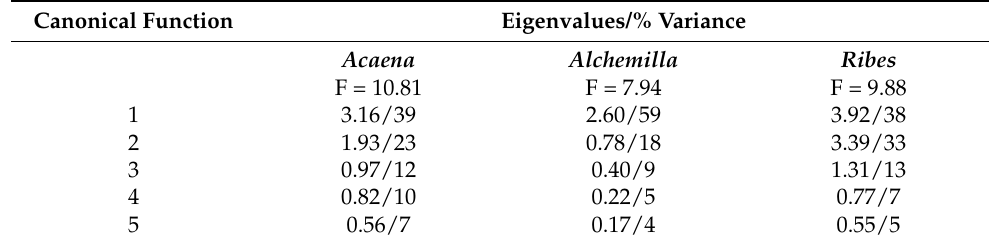
Table 3. Eigenvalues/percentage of variance and F Wilk’s lambda ( p < 0.0001) for each species